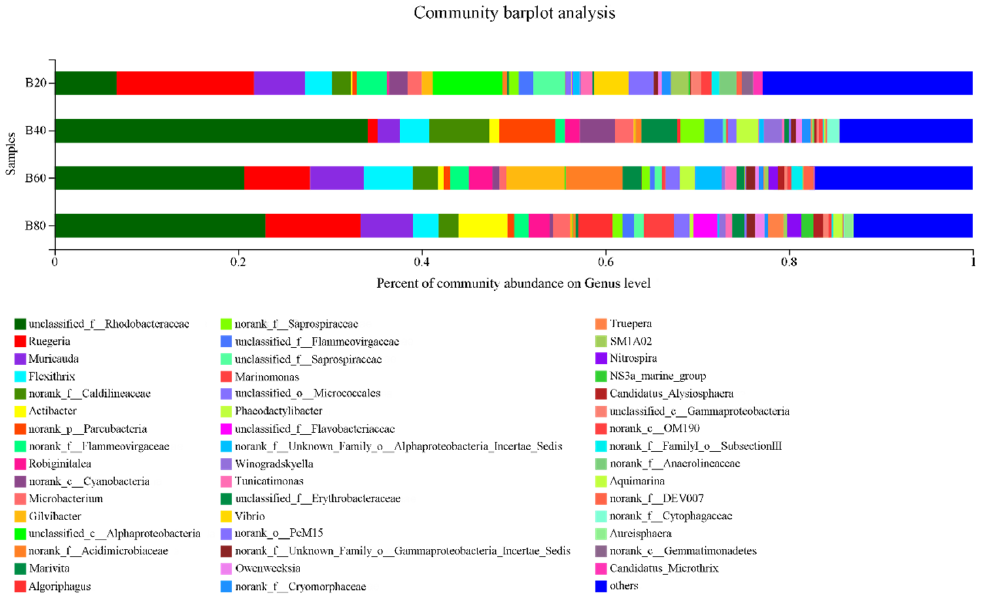
Figure 5. component abundances at the genus level of four periods. Figure 5. Component abundances at the genus level of four